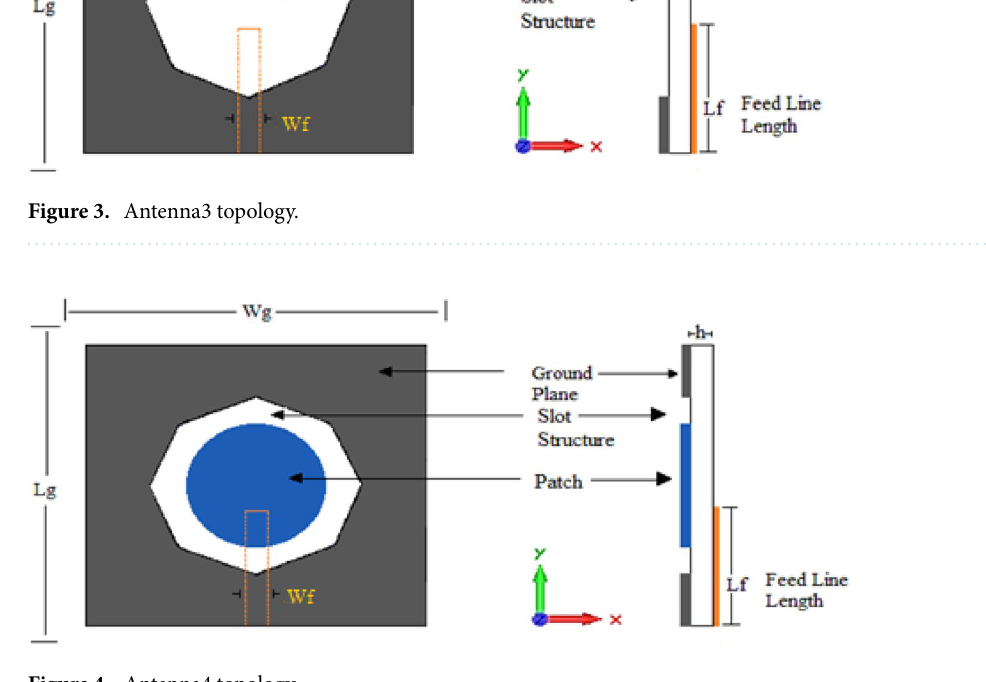
Figure 4. Antenna4